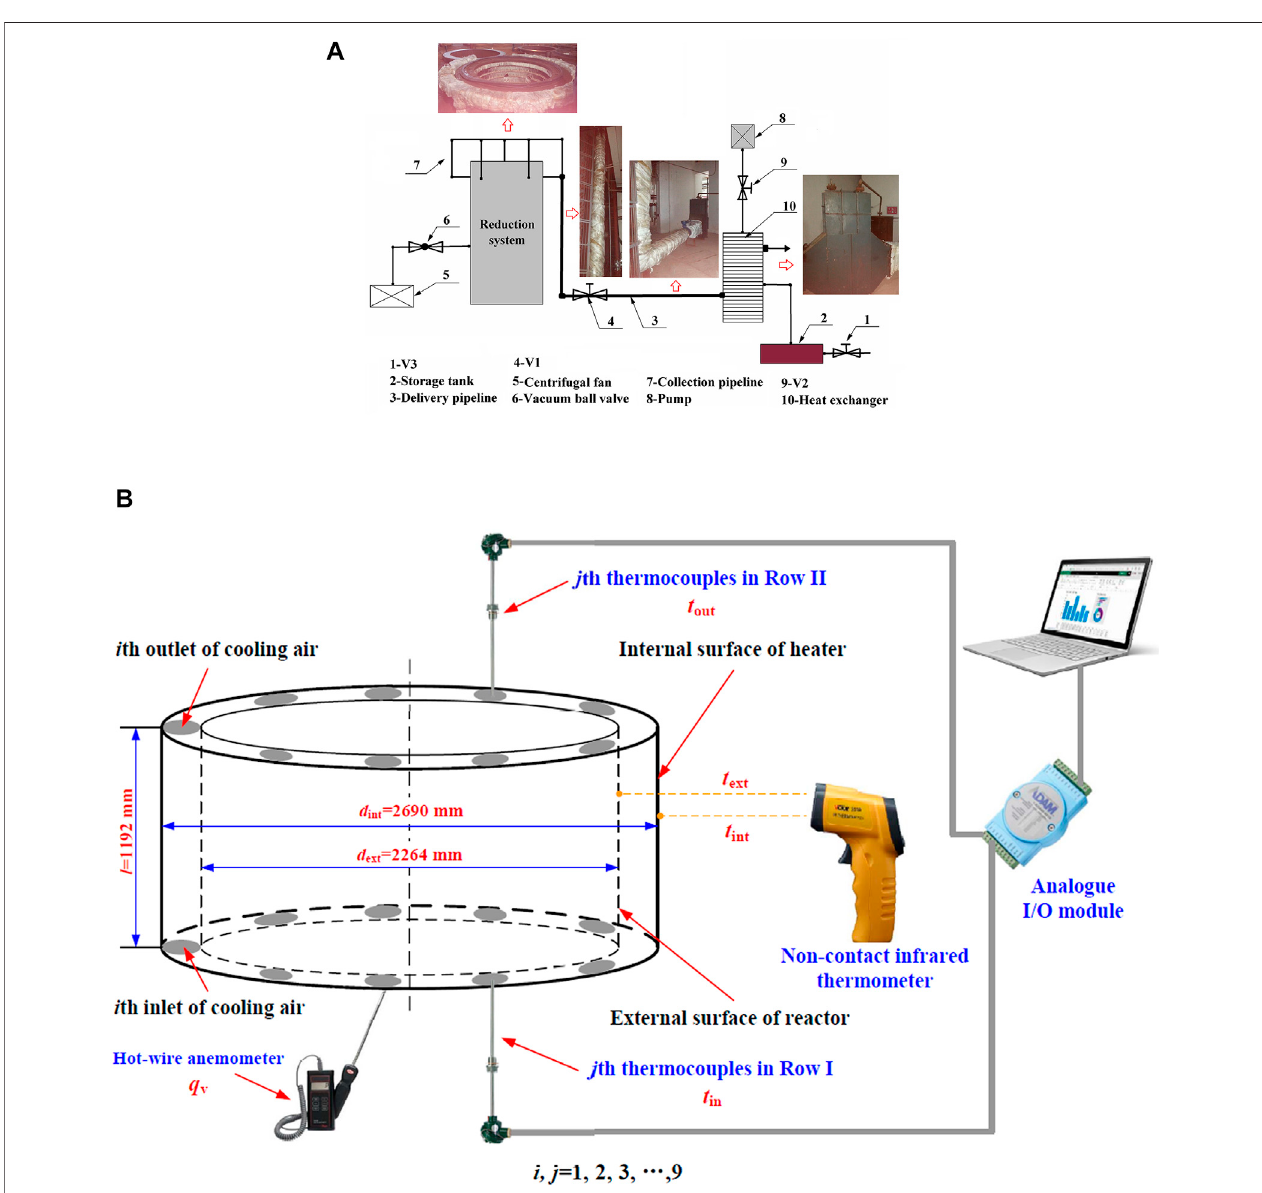
FIGURE 1 | System for: (A) enhancing heat transfer and recovering waste thermal energy for the Kroll equipment (Wang et al., 2017b) and (B) the experimental apparatus and measurements.